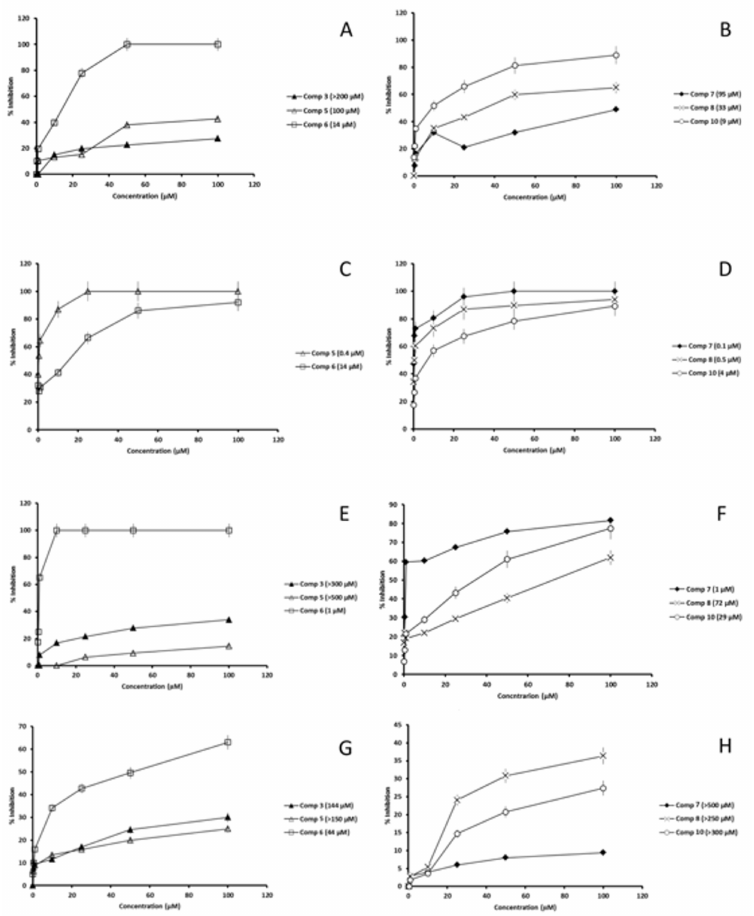
Figure 5. SOD inhibition assay. Representation of the inhibition of 3 , 5 – 8 and 10 against: ( A , B ) L. braziliensis Fe-SOD ( C , D ) L. donovani Fe-SOD ( E , F ) L. infantum Fe-SOD and ( G , H ) human CuZn-SOD. Each drug concentration was tested in triplicate. Values are the means of four separate determinations ± standard deviation. In brackets: IC 50 value, calculated by non-linear regression